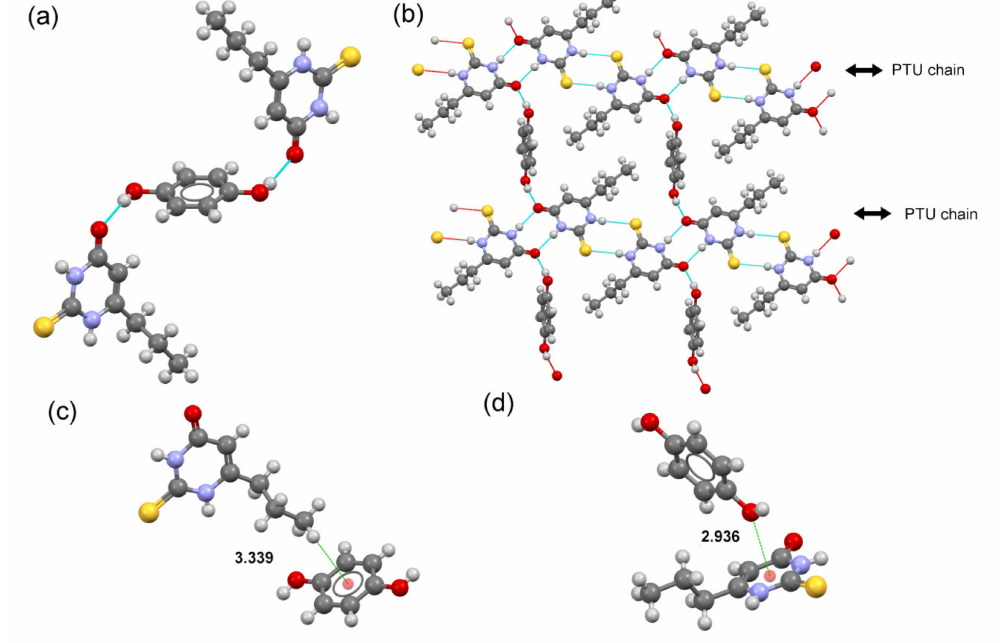
Figure 6. ( a ) Asymmetric unit in cocrystal PTU–HQ. HQ molecule is located in an inversion center. ( b ) Fragment of the 2D layered structure generated by H-bonds and C-H ··· π interactions. ( c ) Detailed view of the C-H ··· π interaction between PTU and CAT molecules (distance in Å). ( d ) Detailed view of the lone pair ··· π interaction between CAT and PTU molecules that connects layers to give a 3D structure (distance in